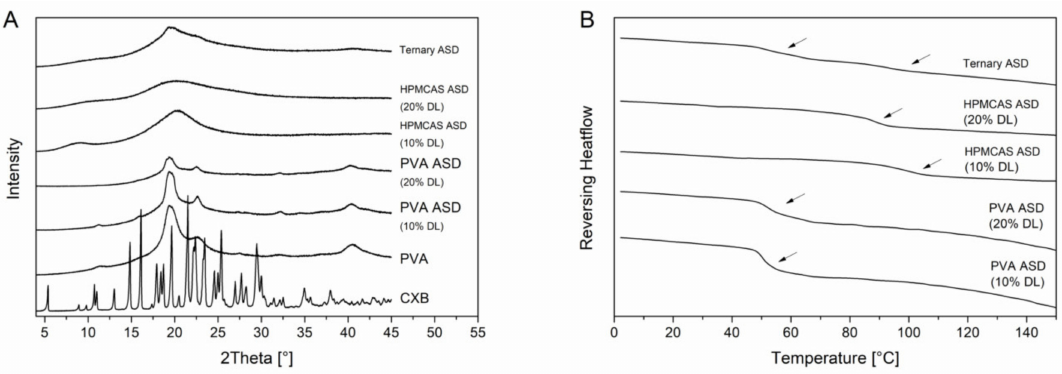
Figure 4. Solid state of the ASDs. X-ray powder di ff raction (XRPD) di ff ractograms ( A ). Di ff erential scanning calorimetry (DSC) thermograms ( B ), glass transition temperatures are indicated by the